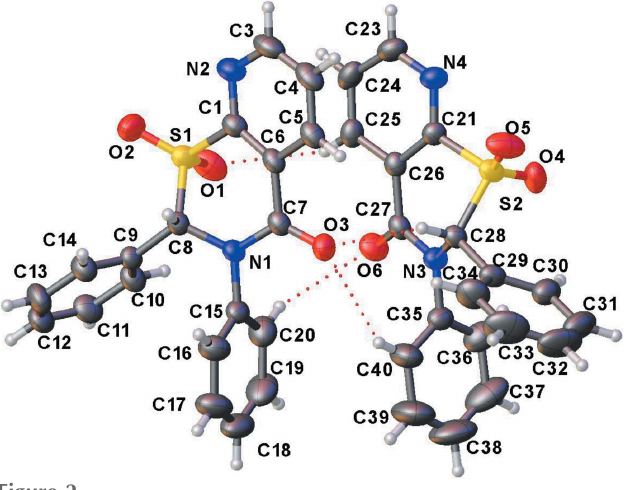
Figure 2 The asymmetric unit of 2 with displacement ellipsoids drawn at 50% probability level.